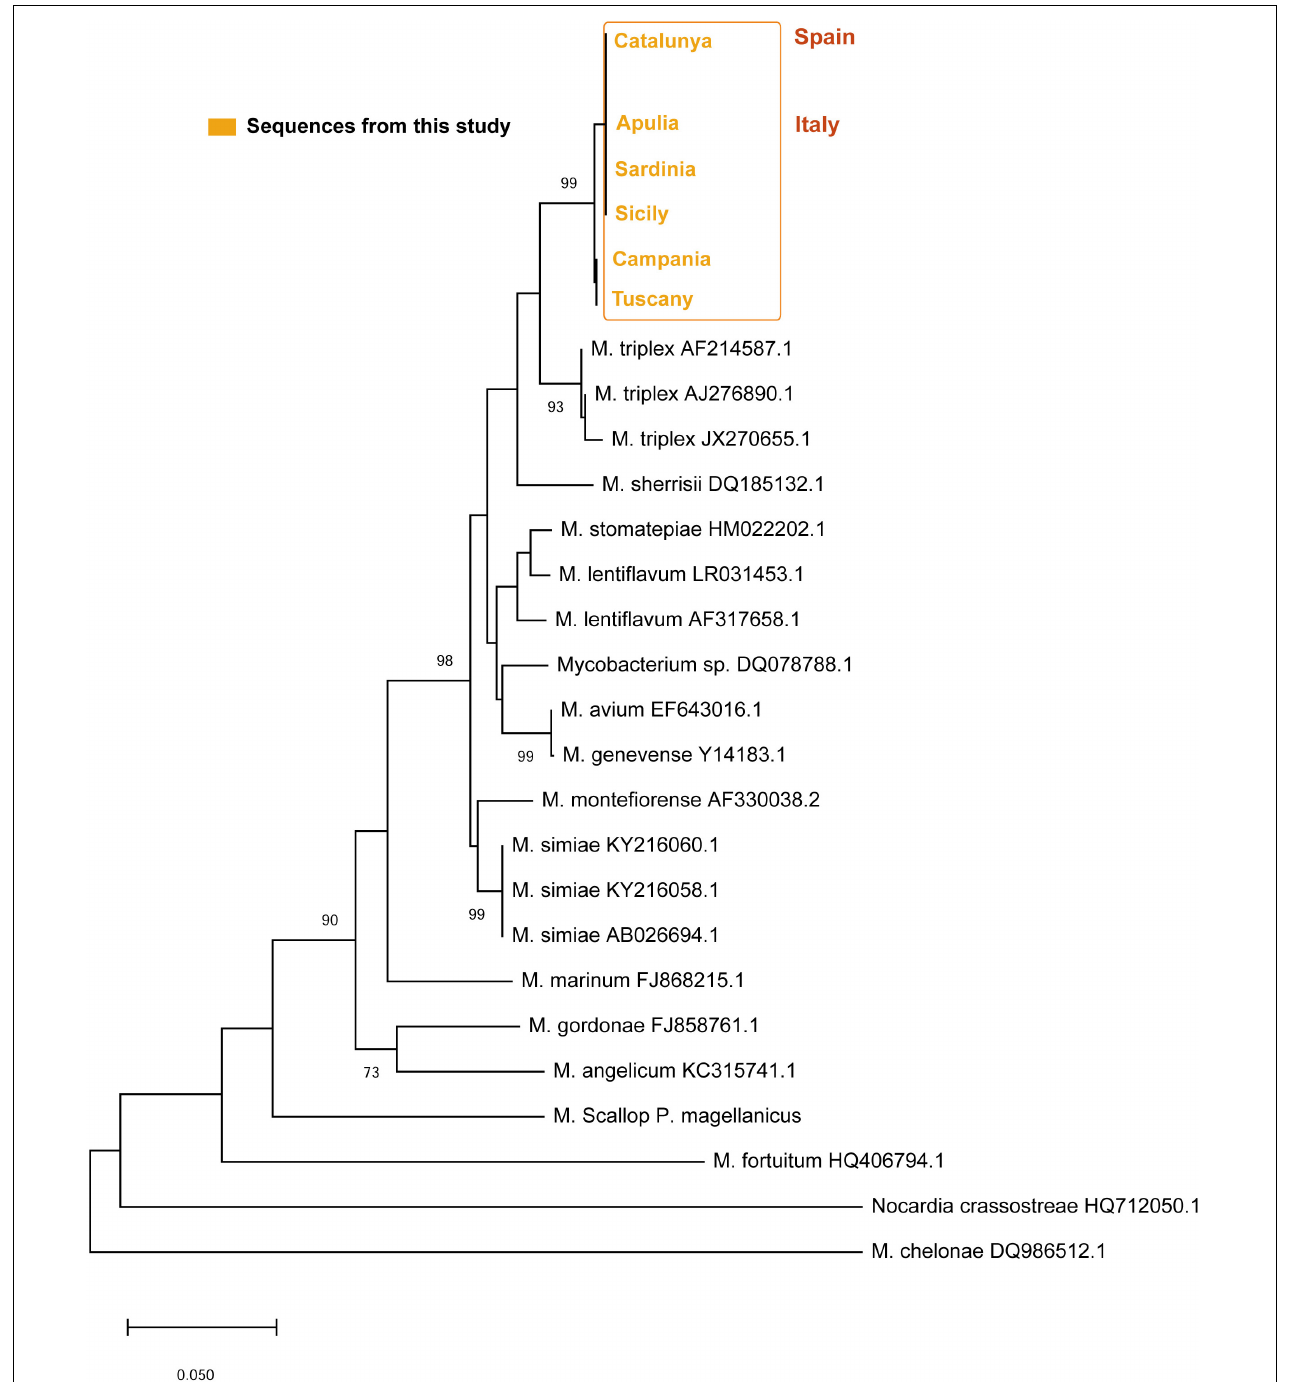
FIGURE 8 | Neighbor-joining tree of the ITS rDNA sequences. The analysis involved 21 nucleotide sequences and a total of 303 positions in the final dataset. The percentages of bootstrap replicates are shown next to the branches.